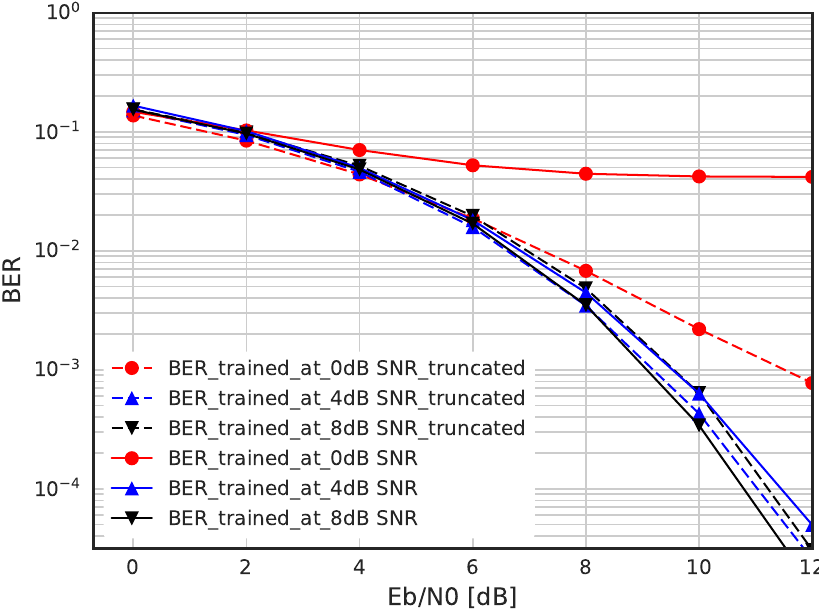
Figure 12. BER performance for Gaussian and truncated Gaussian noise when η = 0, − 4, − 8